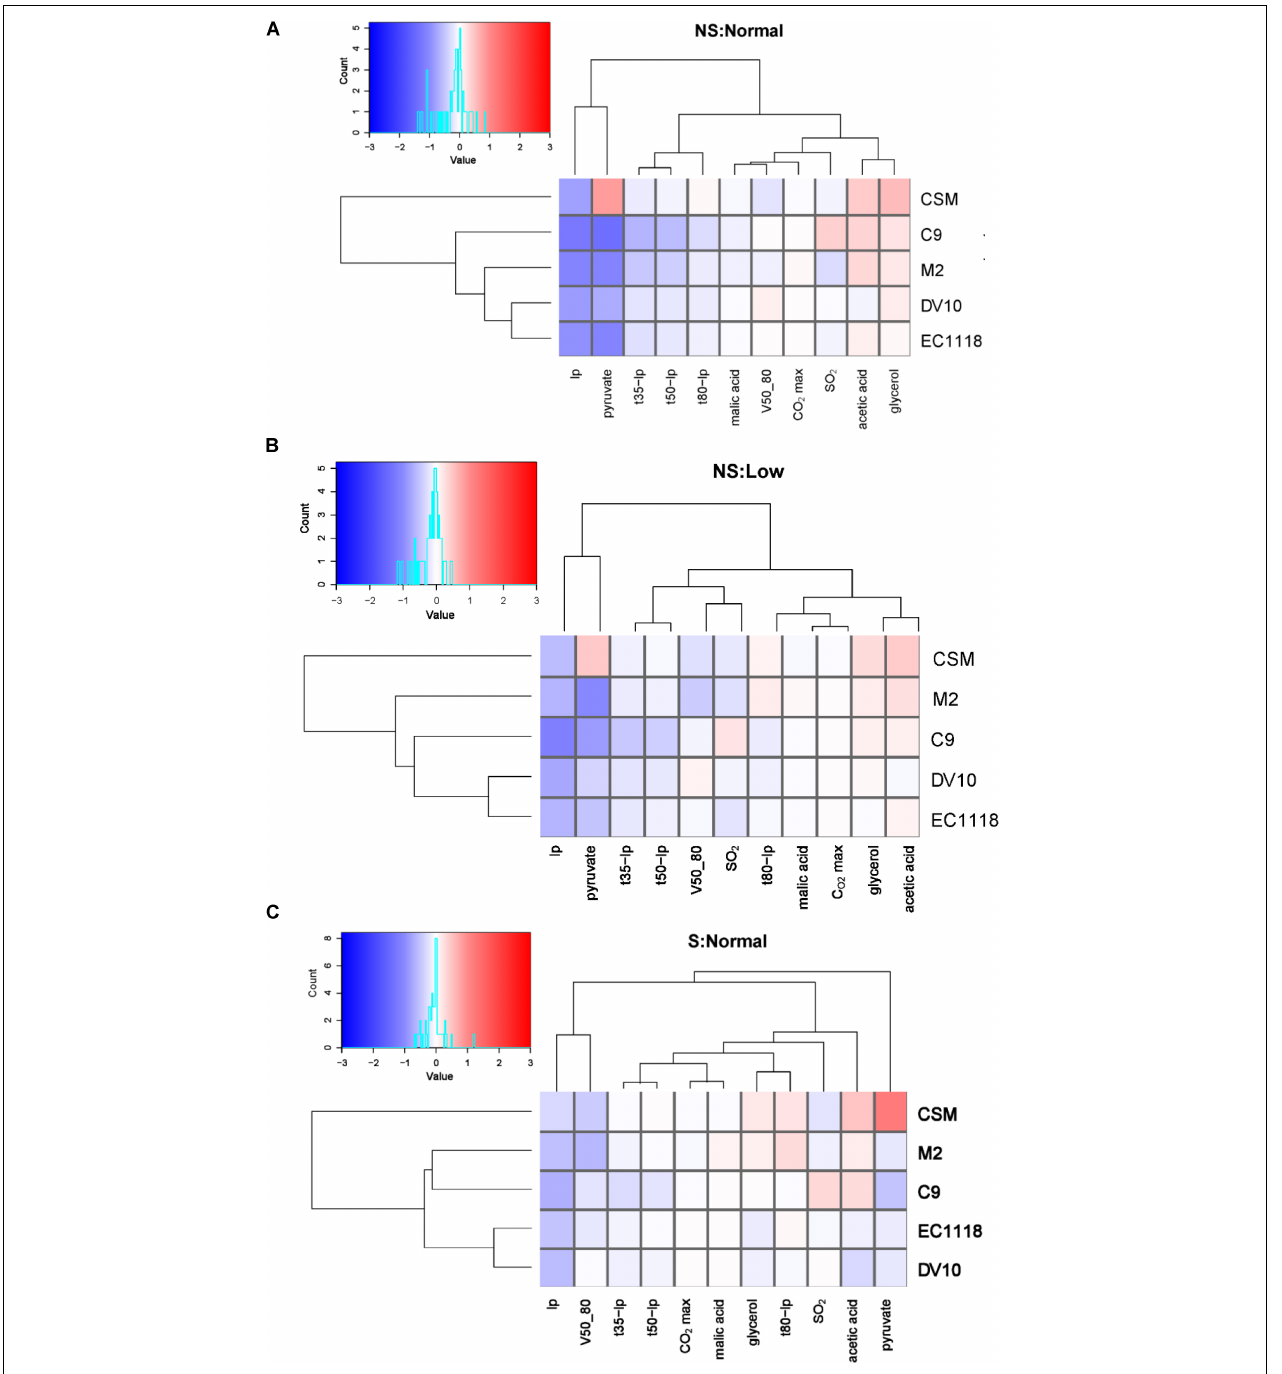
FIGURE 2 | The haploid wine strain shows a similar behavior to commercial strains. Heatmaps showing relative changes in the kinetics and end-product concentrations of the selected wine strains (C9, CSM, EC1118, DV10, and M2) relative to the laboratory strain for three conditions. (A) No shaking: normal nitrogen; (B) No shaking: low nitrogen; (C) Shaking: normal nitrogen. Log 2 of the normalized data is shown, with color indicating a higher (red) or lower (blue) value than the reference strain. The clustering of parameters and strains shows Euclidean distance.